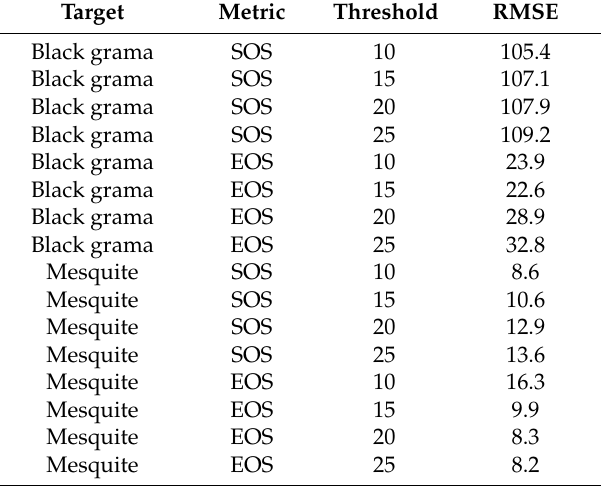
Table 2. Summary of root mean square error (RMSE) as the absolute difference in the number of days for comparisons of field-observed growing season start (SOS) and end (EOS) dates with those derived from phenocam GCC using the Timesat with four percent seasonal amplitude thresholds.